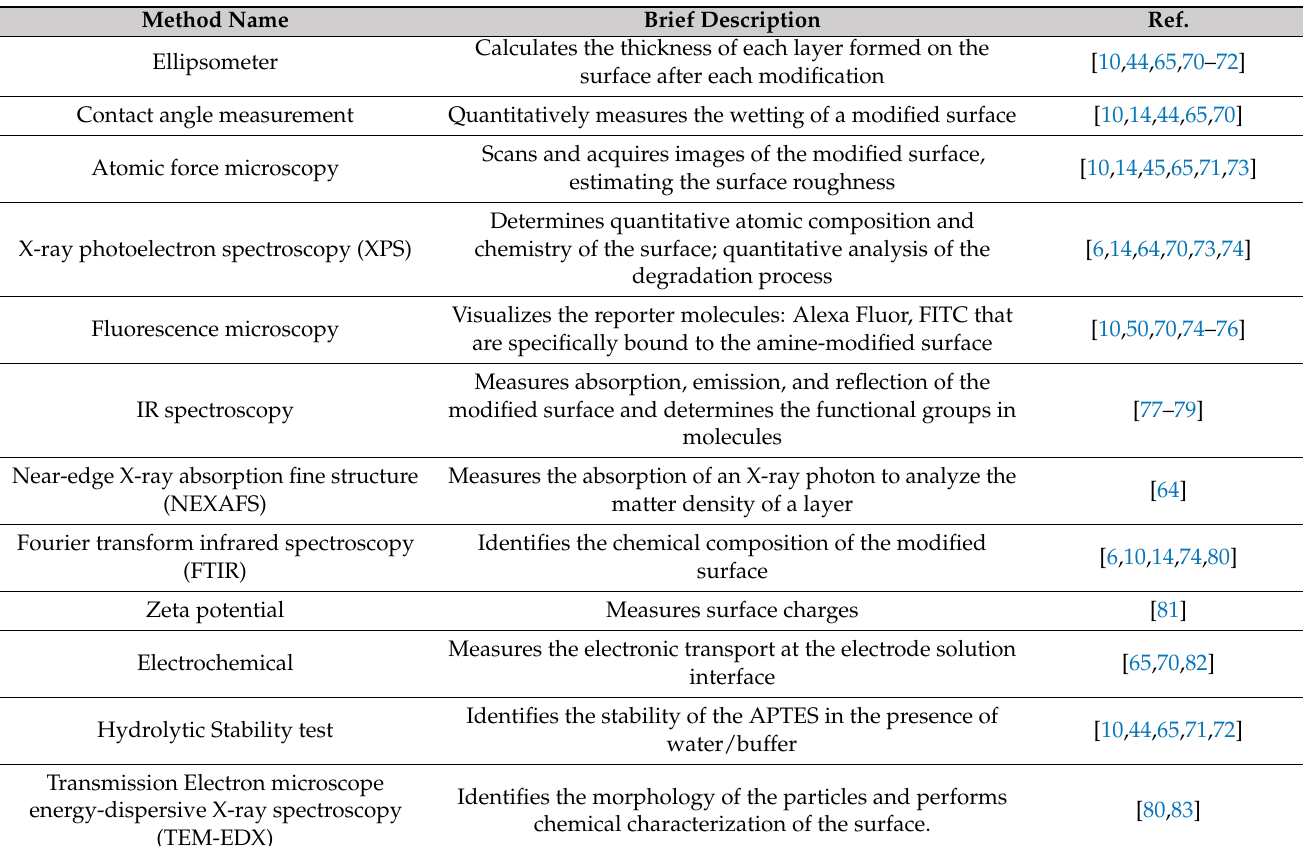
Table 1. List of methods used for inspecting and confirming APTES monolayer and/or multilayer formation on oxide